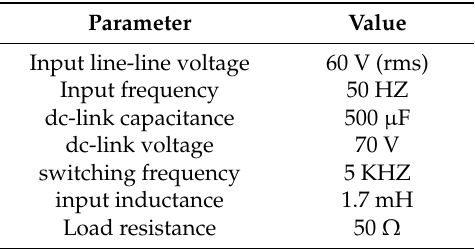
Table 4. Experimental Parameters for